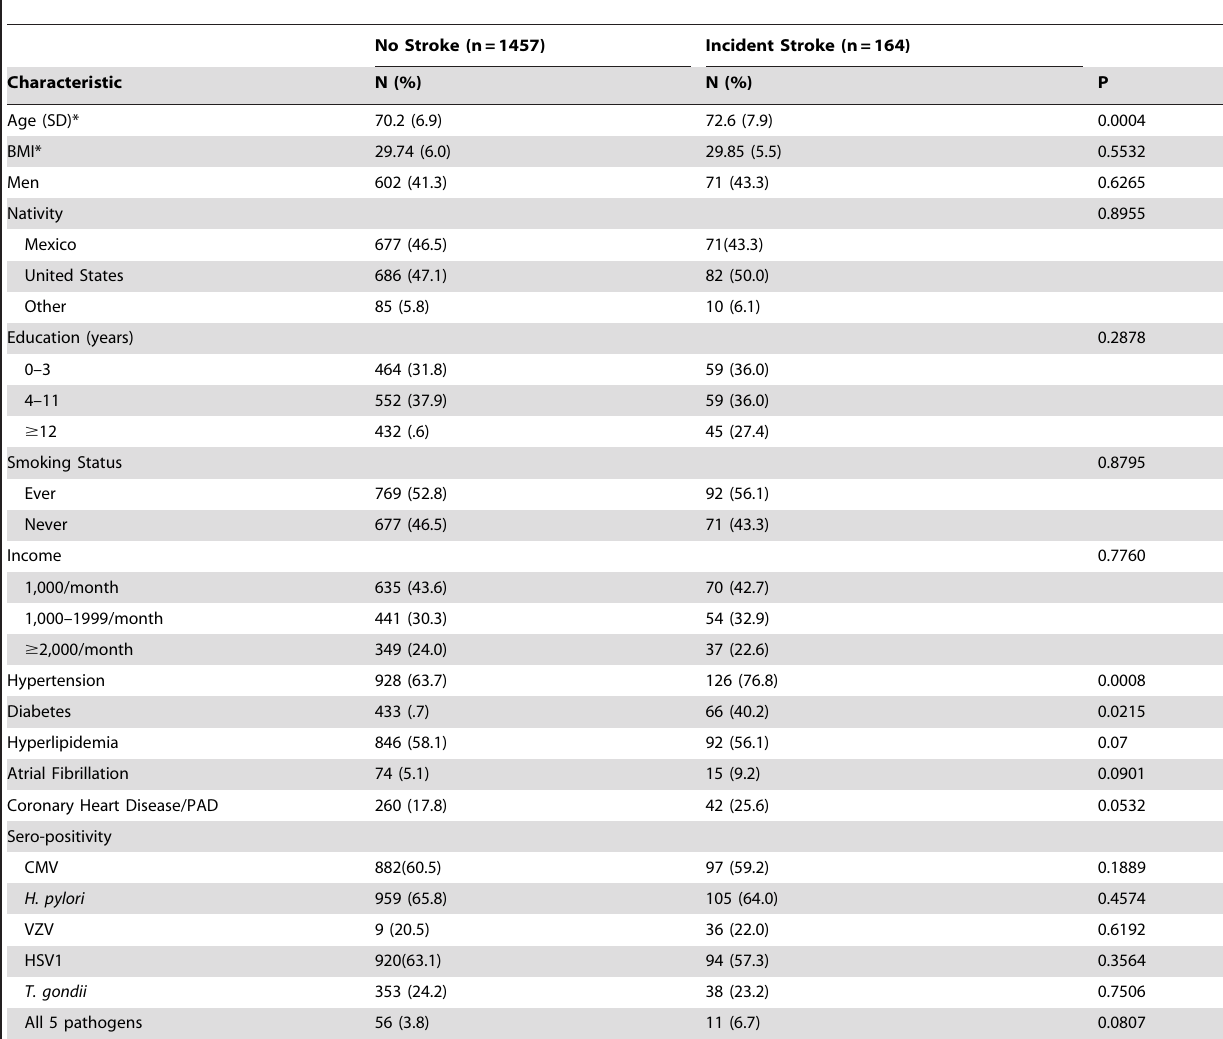
Table 1. Baseline Participant Characteristics by Incident Stroke Status, SALSA, California,